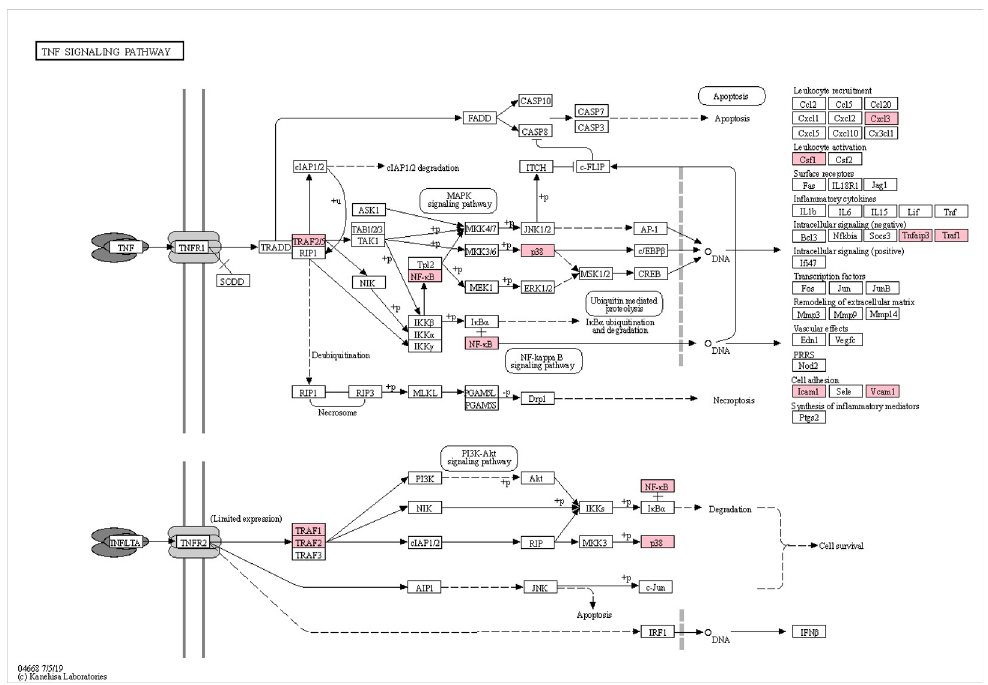
Fig 2. Putative changes in the TNF signalling pathway induced by sPIF treatment. Red boxes are proteins encoded for by DEGs, with reduced expression following sPIF treatment, as identified by STRING analysis, based on P adjusted values ( P adj = 3.8 x 10 − 7 ).